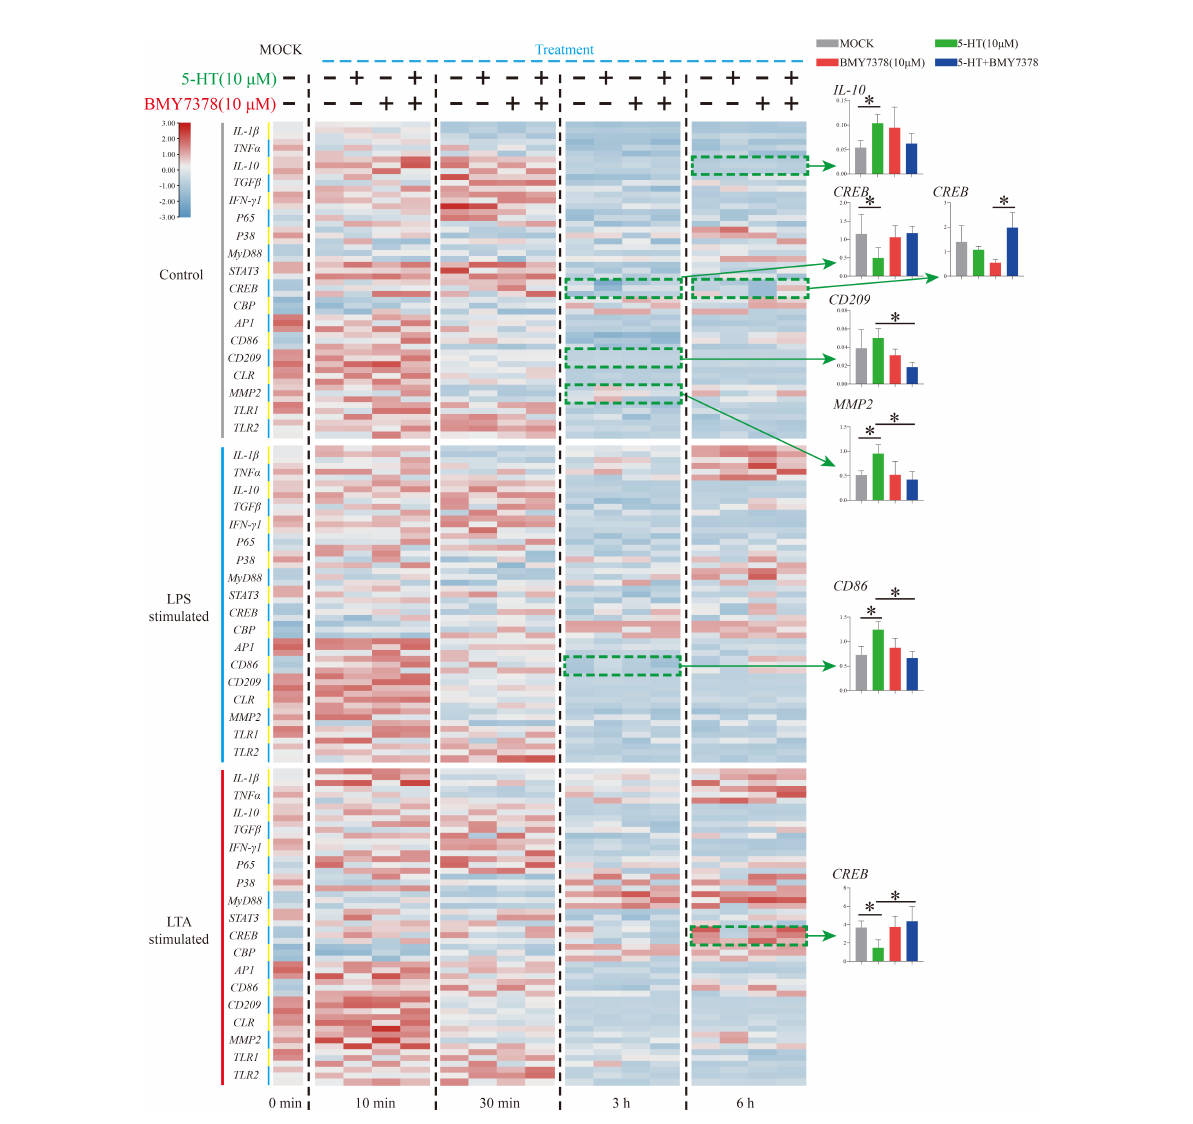
FIGURE 6 The expression patterns of numerous immune-related genes detected via qRT-PCR at different time points among three model groups with 5- HT or/and BMY7378 treatment. n = 3. The signi fi cant difference analysis at each time point was performed via student ’ s t-test (compared in pairs) and the all signi fi cant different results were further displayed by the histograms on the right as well as indicated with asterisks ( p < 0.05). See Table S2 for the expression details of candidate